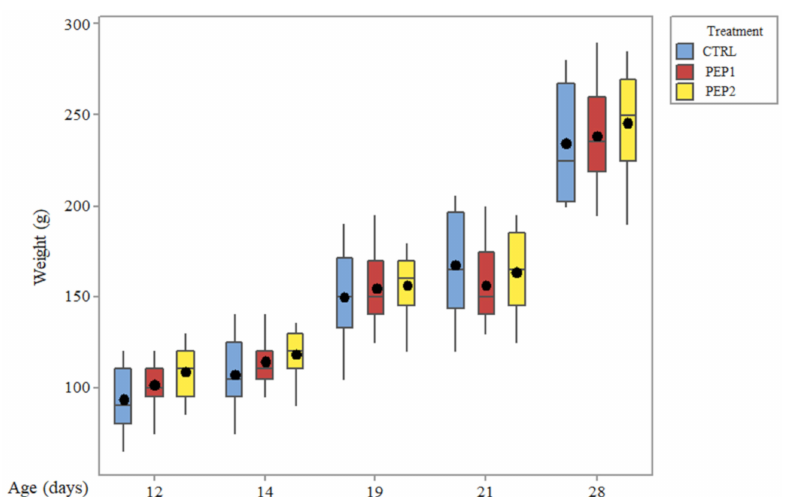
Figure 8. Boxplot of weight distribution according to the treatments and infection time to which the chicks were